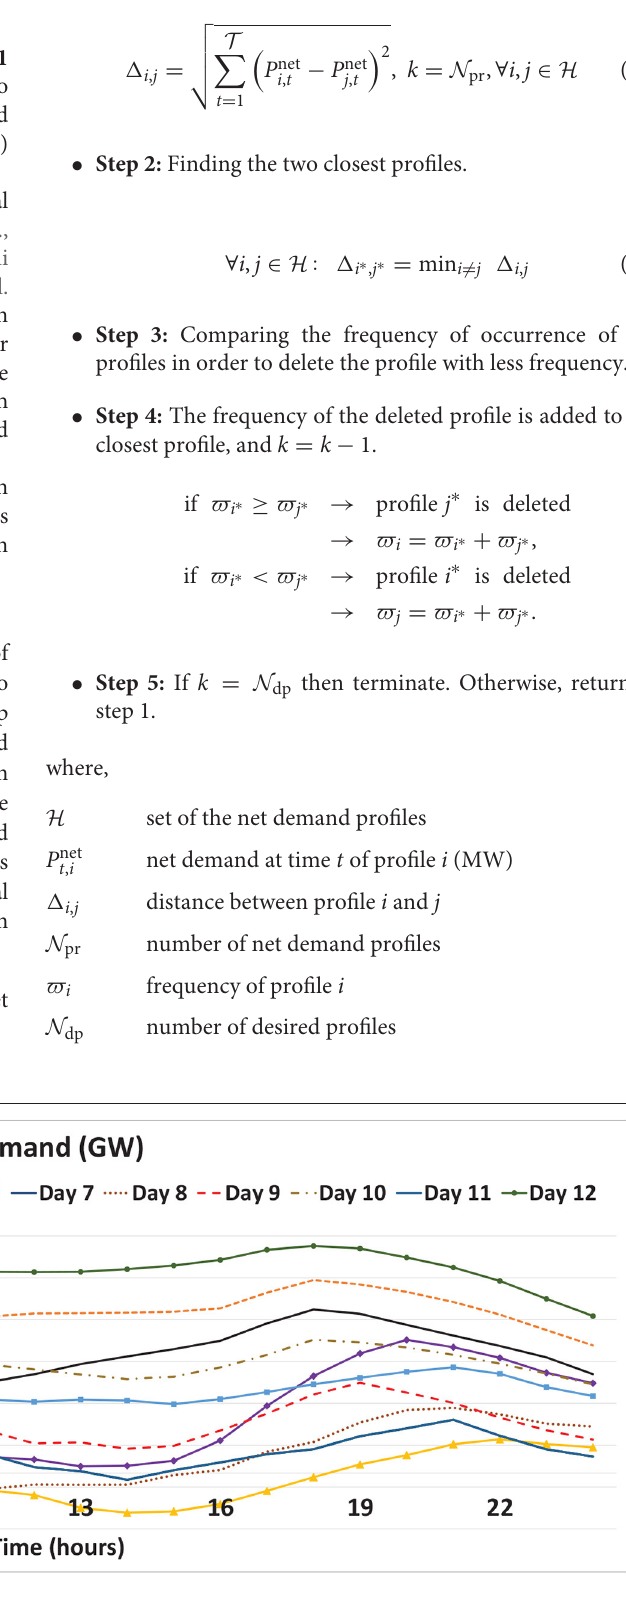
FIGURE 4 | Net demand profiles after the demand clustering